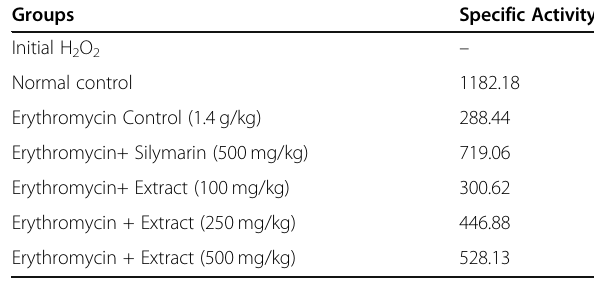
Table 8 Effect of ethanol fruit extract of F. benghalensis on the activity of the antioxidant enzyme (Catalase) in goat liver after Erythromycin administration